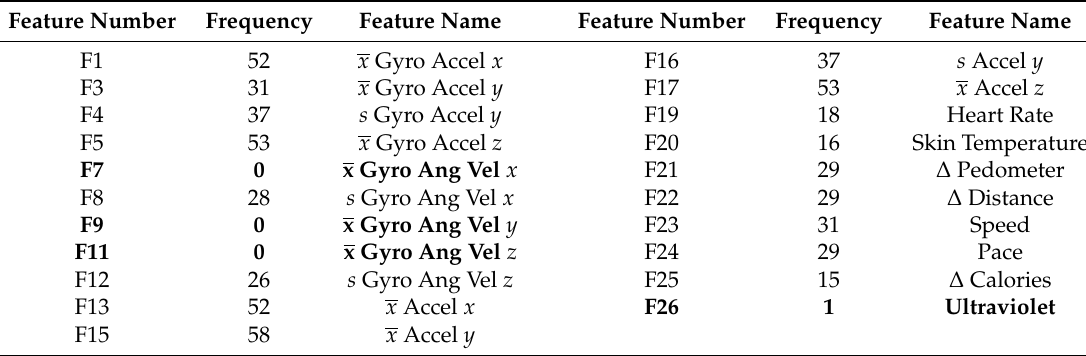
Table 4. Principal Component Analysis results for feature selection in the PRIDE